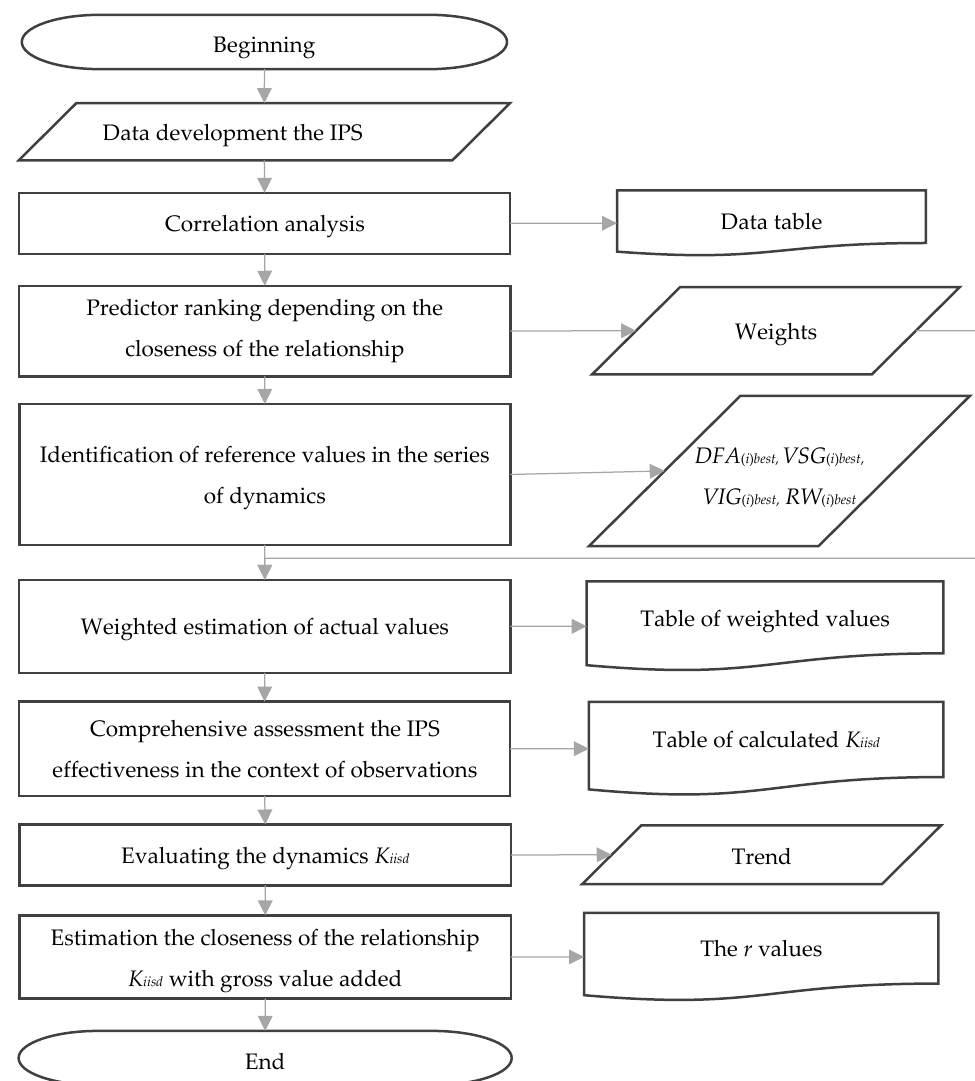
Figure 1. The author ’ s methodology algorithm for assessing the effectiveness of innovative industrial systems.